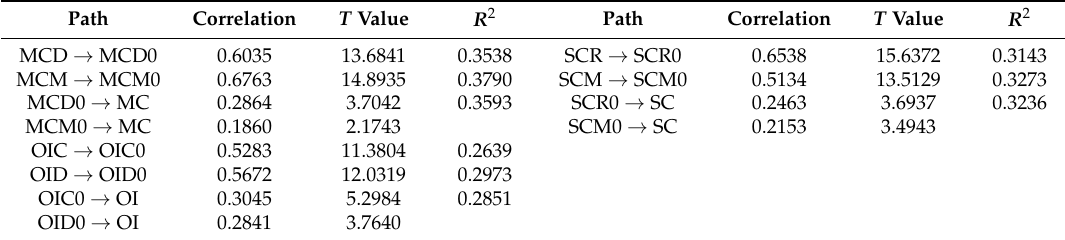
Table 4. The coefficients, T values and R 2 .